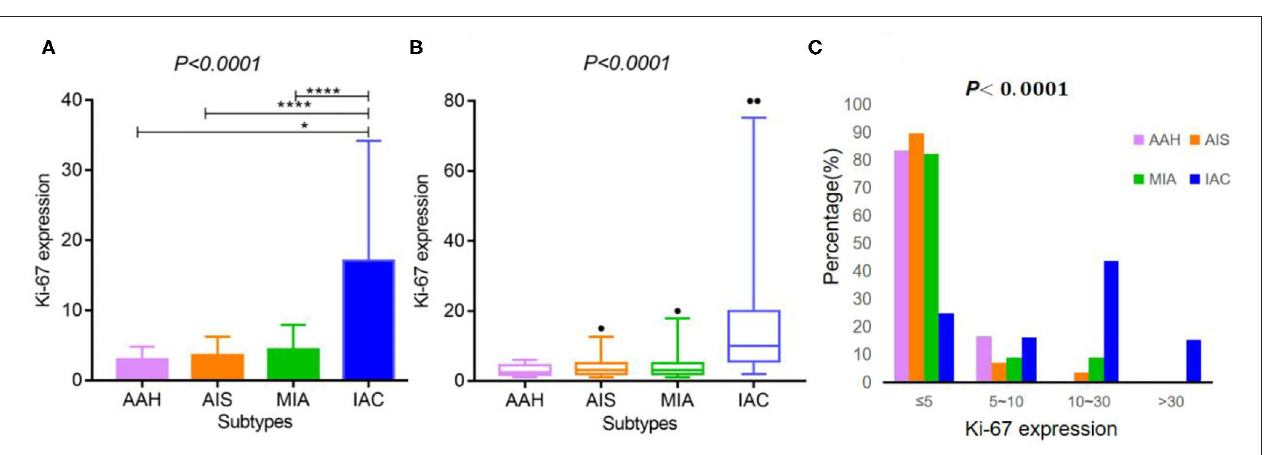
FIGURE 2 | Ki-67 expression according to the histological subtypes of lung adenocarcinoma. (A,B) Ki-67 expression differed across various lung adenocarcinoma subtypes [ A : mean ± SD, B : median (2.5–97.5%)]. (C) The expression distribution of Ki-67 according to the histological subtypes of lung